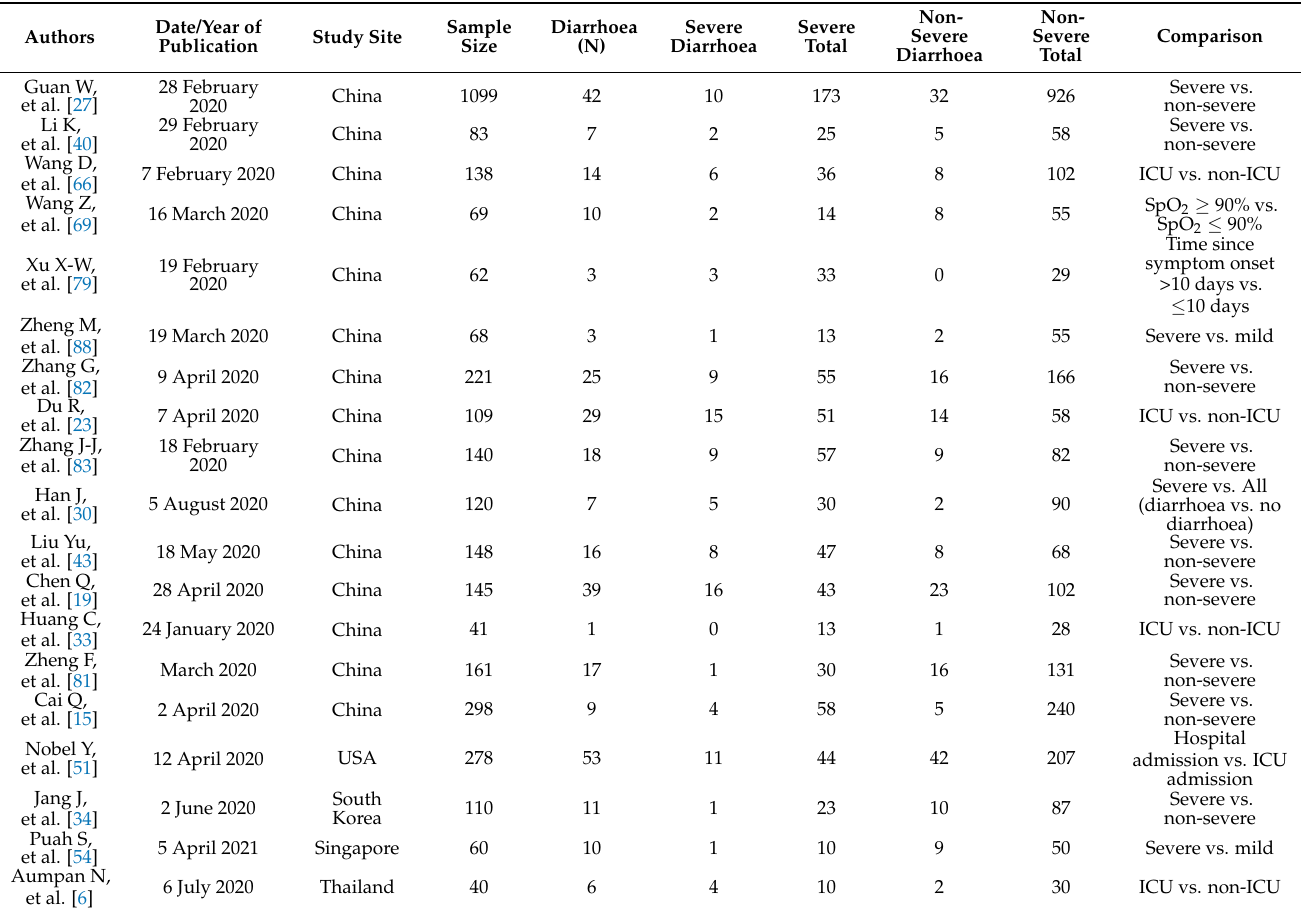
Table 3. COVID-19 infection with diarrhoea: summary of severe versus non-severe